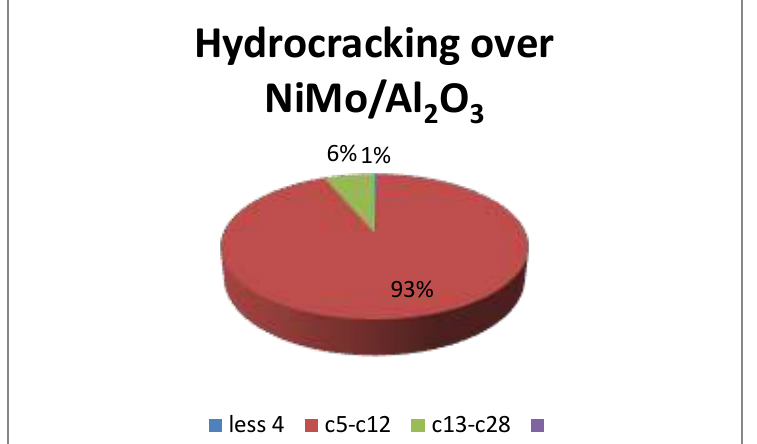
Figure 8: catalytic hydrocracking components over NiMo/Al 2 O 3 catalyst.